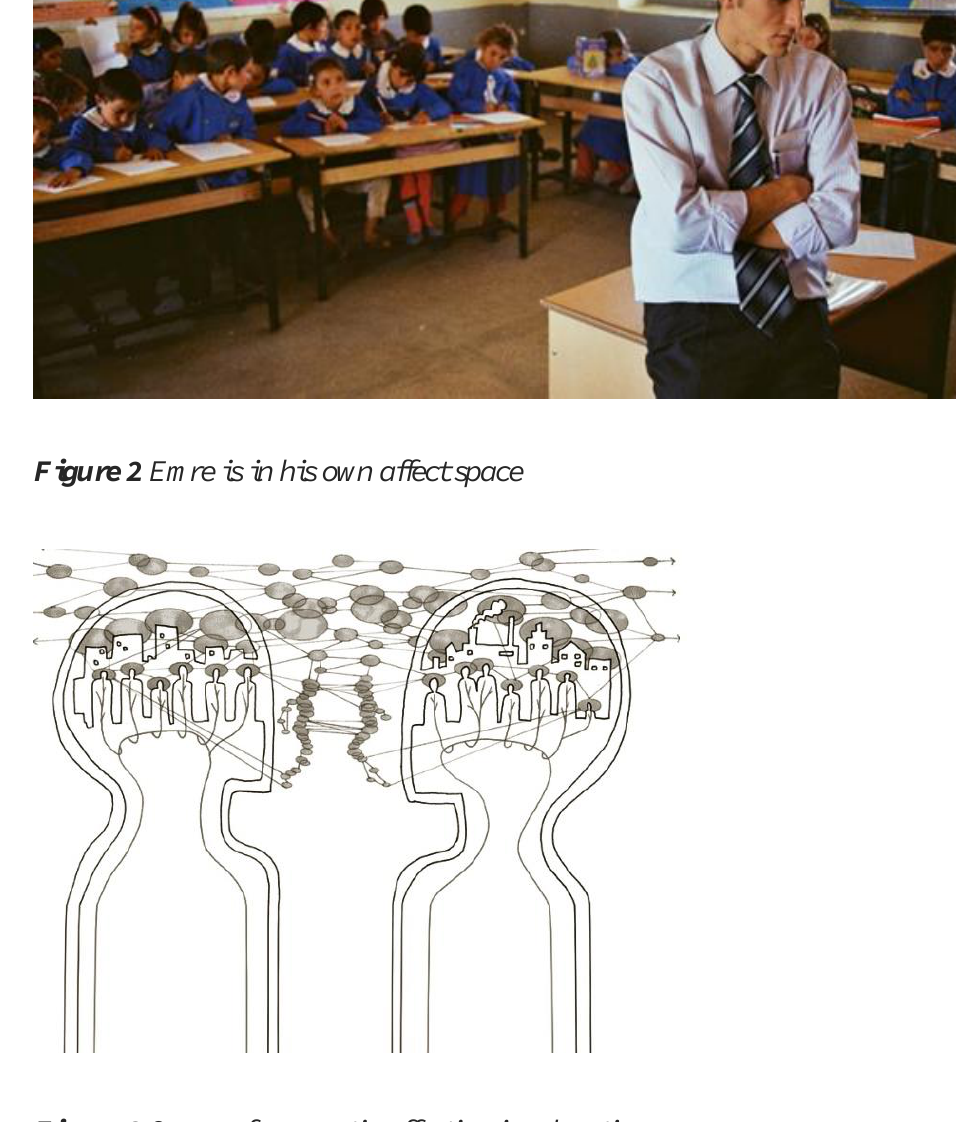
Figure 3 Space of ryzomatic affection in